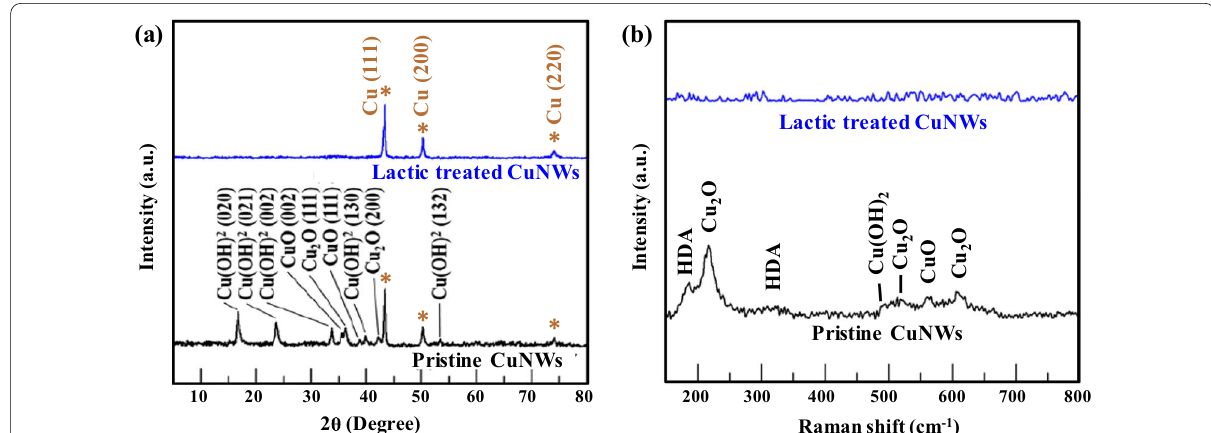
Fig. 2 a XRD patterns of the CuNWs before and after lactic acid treatment. The intensive peaks correspond to the (111), (200), and (220) crystal planes of the face‑centered cubic structure of Cu, and no extra signals appear after the lactic acid treatment, indicating the high purity of the CuNWs. b Raman spectra of CuNWs before and after lactic acid treatment. After treatment with lactic acid, the surface HDA and oxides/hydroxides were removed